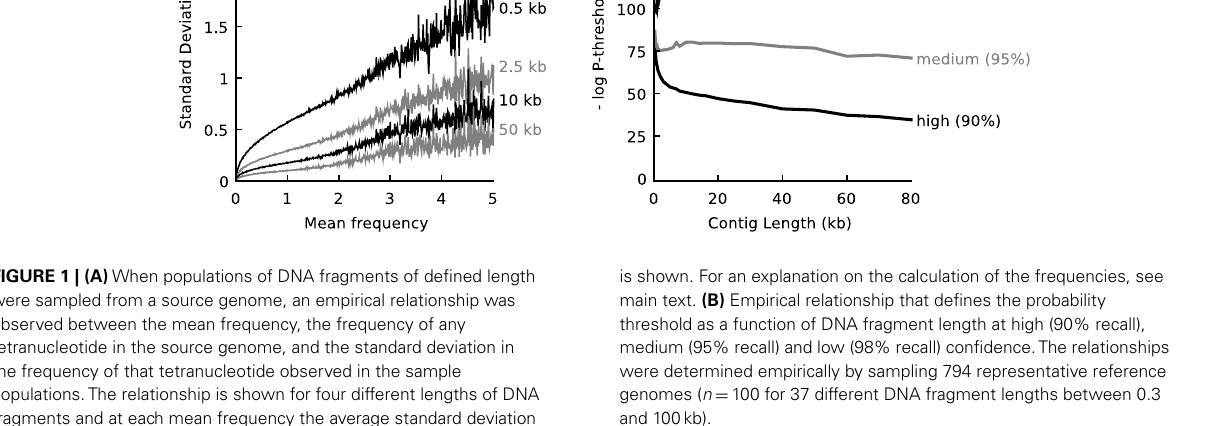
is shown. For an explanation on the calculation of the frequencies, see main text. (B) Empirical relationship that defines the probability threshold as a function of DNA fragment length at high (90% recall), medium (95% recall) and low (98% recall) confidence.The relationships were determined empirically by sampling 794 representative reference genomes ( n = 100 for 37 different DNA fragment lengths between 0.3 and